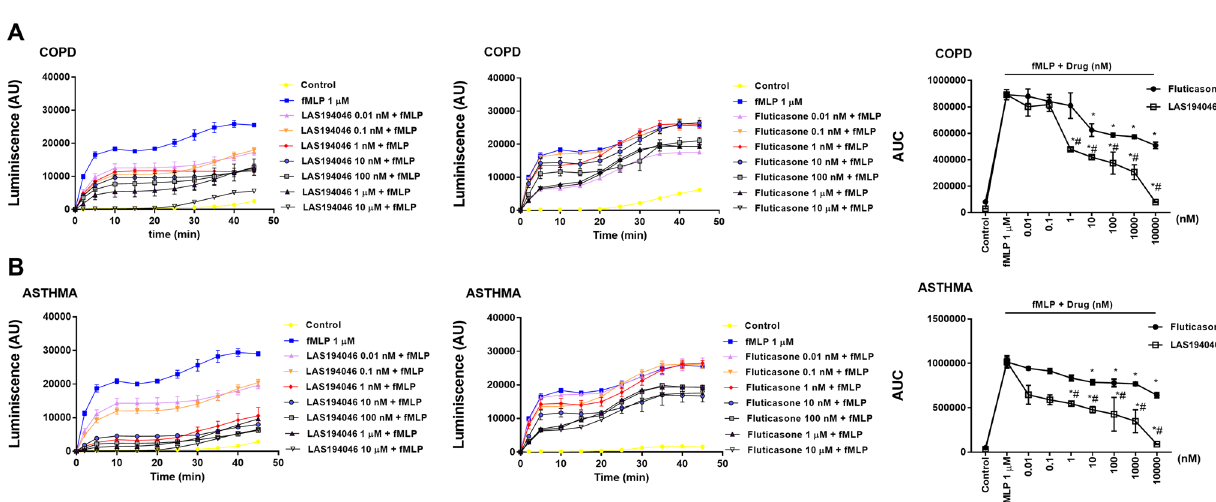
Figure 3. Effects of LAS194046 and fluticasone propionate on human neutrophil superoxide anion formation. Concentration-dependent inhibition of N -Formylmethionyl-leucyl-phenylalanine (fMLP)-induced superoxide anion formation by LAS194046 and fluticasone propionate from peripheral blood neutrophils of ( A ) COPD and ( B ) severe asthma patients. Neutrophils were pre-incubated with LAS194046 or fluticasone propionate during 30 min followed by cell stimulation with fMLP (1 µM) for up to 45 min. The results are expressed as luminescence values [arbitrary units (AU)] and as area under curve generated by luminescence time-curse data as the mean ± SD (n = 3 each for cells from COPD patients in independent experiments with triplicate samples). A two-way ANOVA was followed by a post hoc Bonferroni test. *p < 0.05 vs. control; # p < 0.05 vs. fluticasone (Fig. 1C,D, Supplementary File 1: Table S3). In sputum neutrophils from COPD patients, the maximal % inhibi- tion of LAS194046 was 57.27 ± 10.13% and 74.34 ± 3.09 for IL-8 and MMP9 release, significantly higher than maximal % inhibition of fluticasone propionate which reached 40.12 ± 10.30% and 42.14 ± 9.23% inhibition for IL-8 and MMP9 respectively (Fig. 2, Supplementary File 1: Table S3). fMLP 1 µM induced the increase of superoxide anion formation in neutrophils from severe asthma and COPD that was concentration-dependently (0.01 nM–10 μM) inhibited by LAS194046, reaching a maximal % inhibition of 98 ± 2% and 97.8 ± 4% respectively, significantly higher than the maximal % inhibition reached by fluticasone propionate that was 48.1 ± 4% and 45.4 ± 5% (Fig. 3A,B). LAS194046 and fluticasone propionate combination improves anti‑inflammatory and anti‑oxidant effects in neutrophils from severe asthma and COPD patients. Neutrophils were incubated with non-effective concentrations of LAS194046 0.1 nM, fluticasone propionate 1 nM or their com- bination 1 h before cells were stimulated with 1 µg/ml of LPS. While the monotherapy did not reach significant inhibition, the combination of LAS194046 0.1 nM and fluticasone propionate 1 nM reached significant inhibi- tion of LPS-induced IL-8 and MPP9 release in peripheral blood neutrophils from severe asthma and COPD patients (Fig. 4A) as well as in neutrophils from sputum of COPD patients (Fig. 4B). The inhibitory effects of